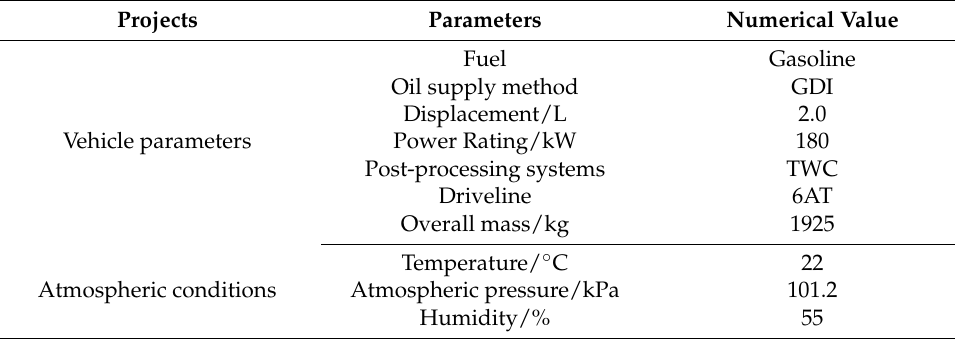
Table 4. RDE test conditions